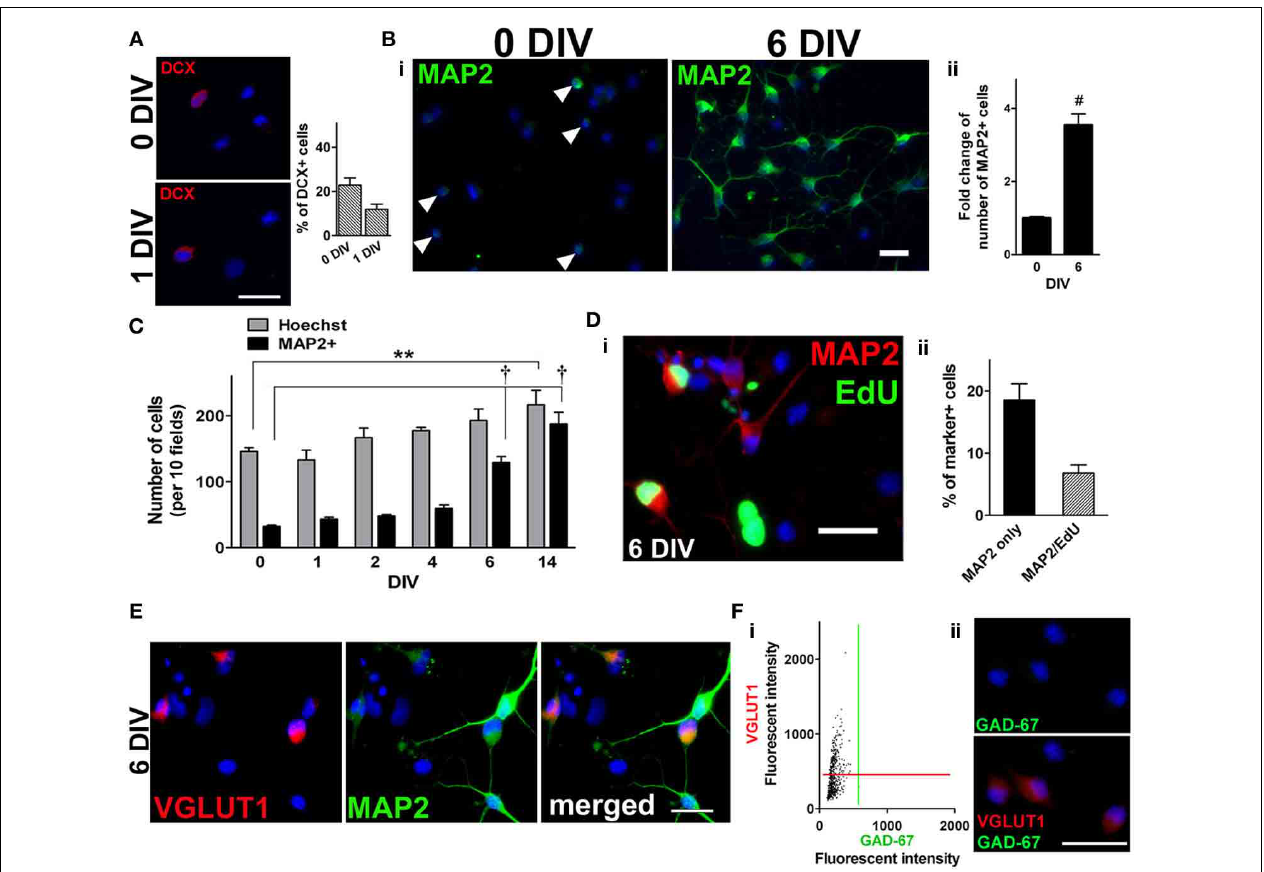
FIGURE 2 | Neuronal differentiation in adult spinal cord NSPC cultures. (A) Immunostaining for doublecortin (DCX) at 0DIV (top left panel) and 1DIV (bottom left panel). Blue indicates Hoechst-stained nuclei. (Right panel) Quantification of the percentage of DCX + cells at both time points (20 random fields with a 40 × objective per coverslip were analyzed, n = 4 coverslips). (B) i, Microtubule-associated protein 2 (MAP2) staining (green) of adult rat spinal cord cultures at 0DIV, arrowheads denote MAP2 + cells (left), and at 6DIV in culture medium containing FGF2 (right). Blue indicates Hoechst-stained nuclei. (ii) Fold change of the number of MAP2 + cells at 6DIV ( n = 13 coverslips from five experiments; # P < 0 . 0001, unpaired t -test). The data was normalized to the mean total number of cells at 0DIV. (C) As the population of NSPCs was enriched, many of the cells differentiated toward a neuronal lineage as the number of MAP2 + cells increased over time (10 random fields with a 40 × objective per coverslip were analyzed, n = 3 coverslips; ∗∗ P < 0 . 01, † P < 0 . 001, One-Way ANOVA Dunnett’s multiple comparison post-test). (D) i,